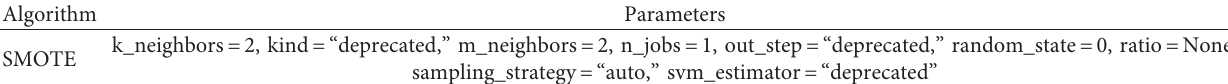
Figure 5: P-R curve and ROC curve of the basic classifiers. (a) PR curve. (b) ROC curve. Table 6: Parameters of SMOTE.